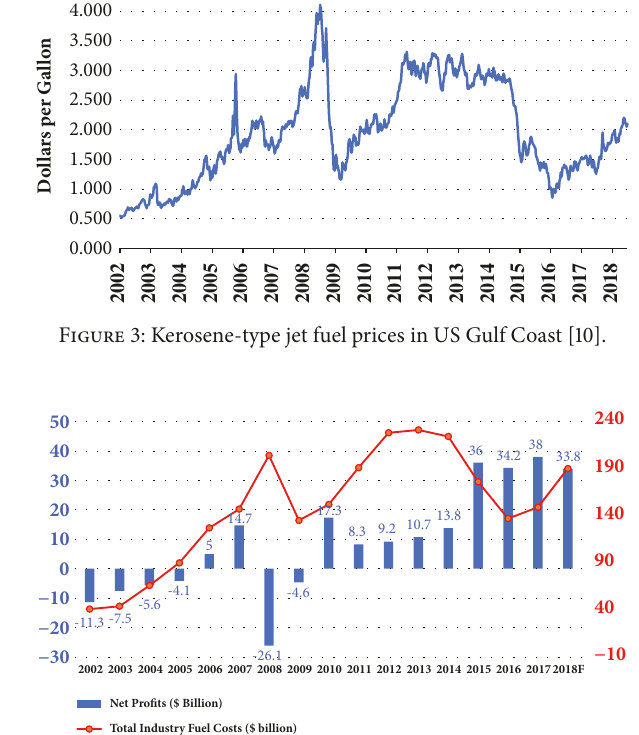
Figure 4: Industry fuel costs and net profits trends in aviation